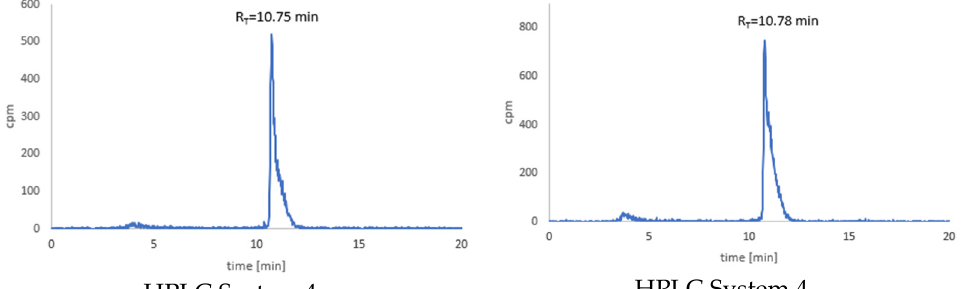
Figure 5. RP-HPLC radiochromatograms (System 4) of the stability studies of the 68 Ga-2 radioconju- gate in Cys ( left , RCP 98.1 ± 1.2%, n = 3) and His ( right , RCP 95.3 ± 2.0%, n = 3) solutions recorded after 3.5 h of